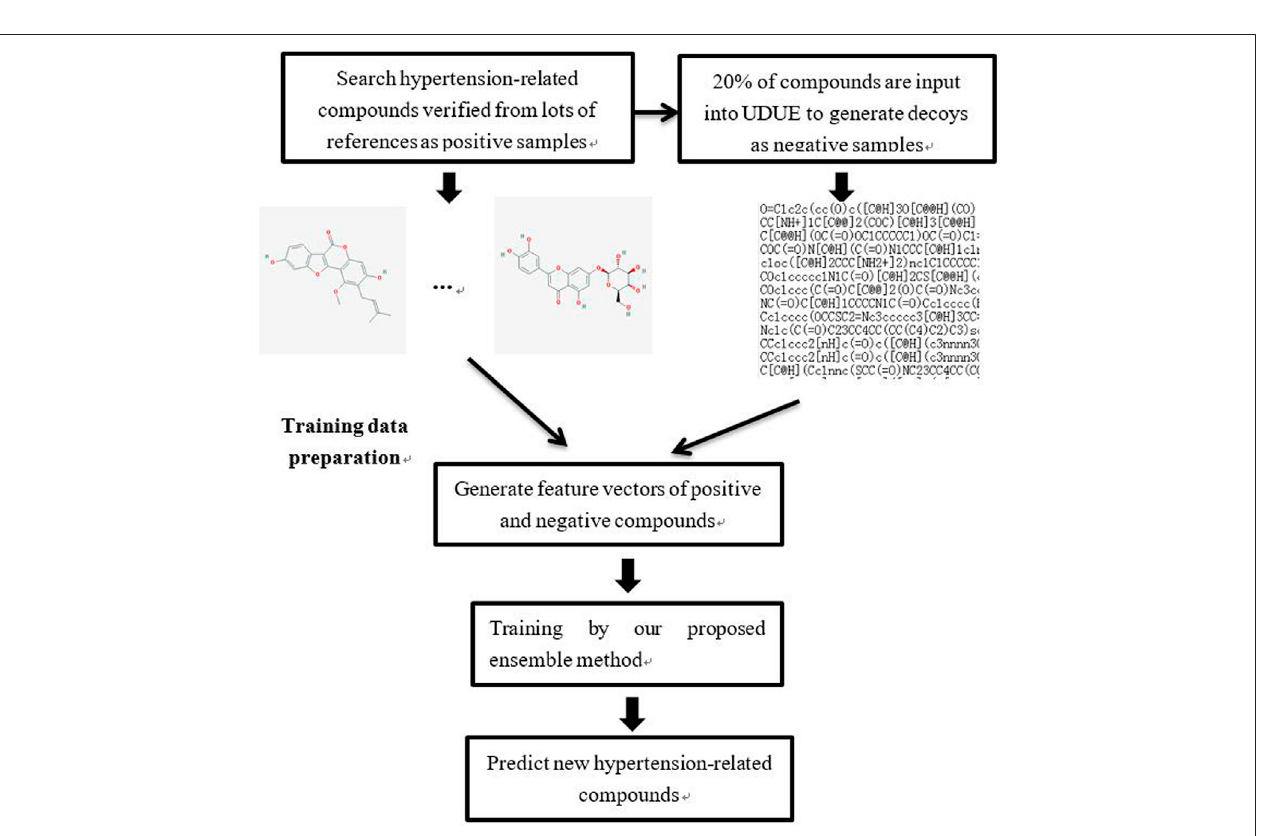
FIGURE 3 | The fl owchart of hypertension-related active compound identi fi cation.